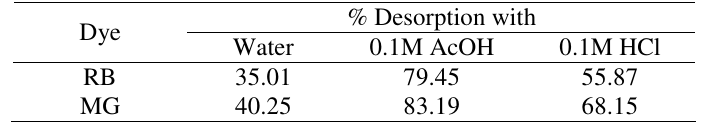
Table 9. Desorption of